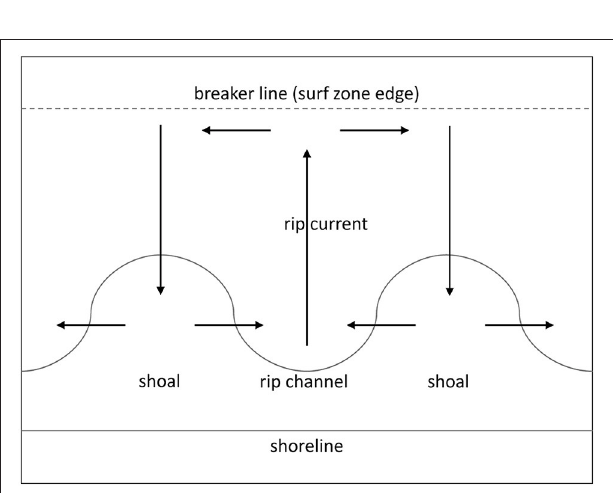
cell concentrations, and how surf zone taxa return to the